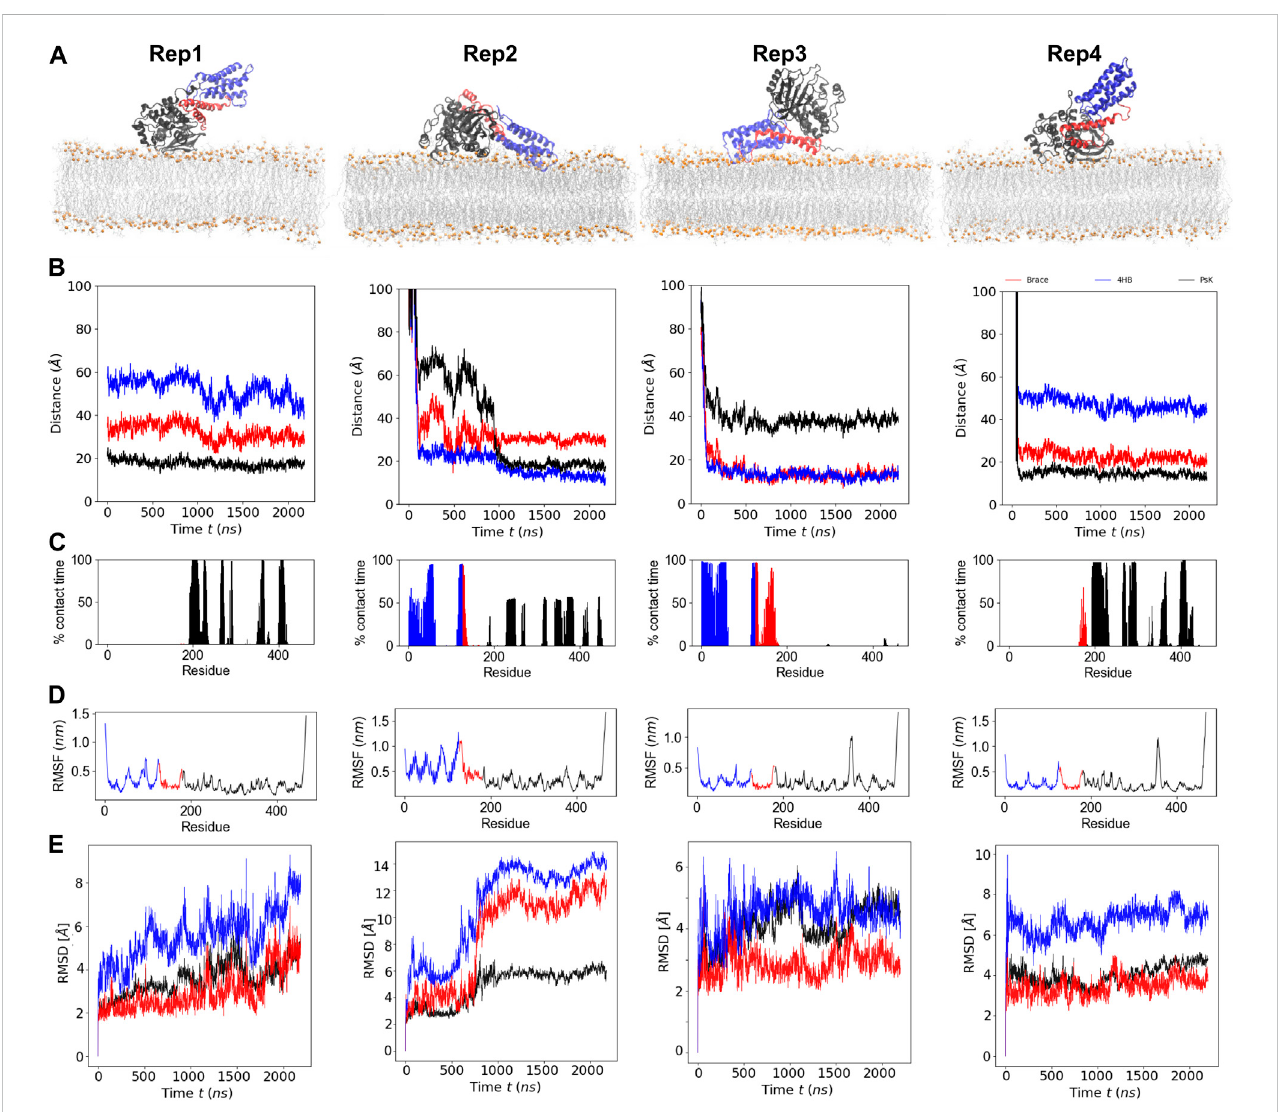
FIGURE 1 BindingconformationanddynamicsofMLKL proteinwithamodelmembrane. (A) FinalboundconformationsofMLKLforeachreplica.The4HBdomain is shown in blue, the brace in red, and the PsK in black. Phosphate atoms of lipids are shown in orange, and fatty acid tails are shown in silver. (B) Center-of- mass distance of the C α in each protein domain with respect to the phosphate groups in the binding lea fl et. (C) Percent of time each residue in contact with anyofthelipidspeciesinthebindinglea fl et. (D) RMSFofproteinresidues. (E) CorrespondingRMSDtimeseriesforeachdomaininthefourreplicas.Values corresponding to 4HB domain residues are indicated in blue, to the brace in red, and to the PsK in black in panels (B – E) , matching the domain colors in panel (A)